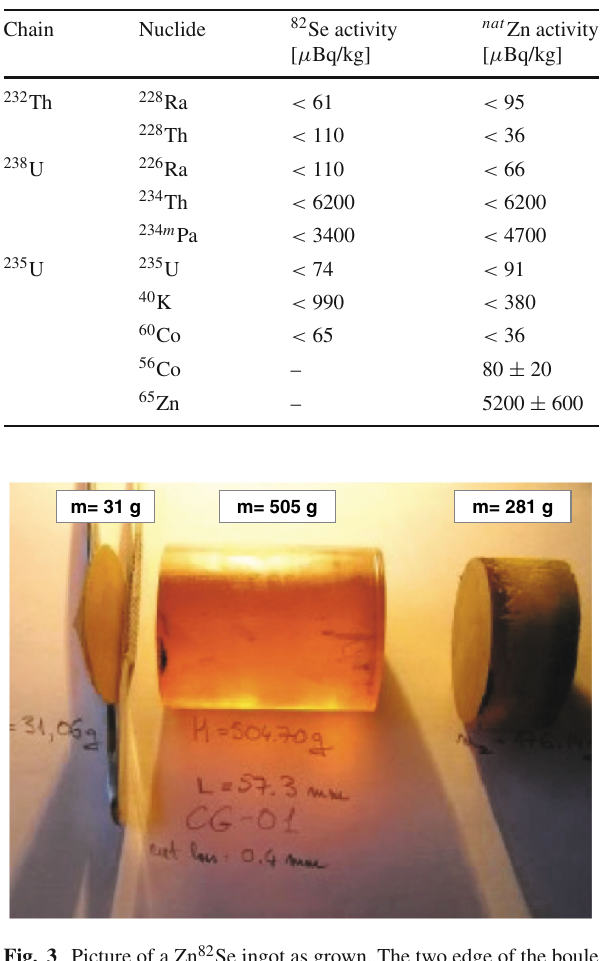
Table 1 Internal radioactive contamination for 2.5 kg of 96.3% enriched 82 Se metal beads and for 2.5 kg of nat Zn. Limits are com- puted at 90% C.L.. The measurements were carried out on October 2014